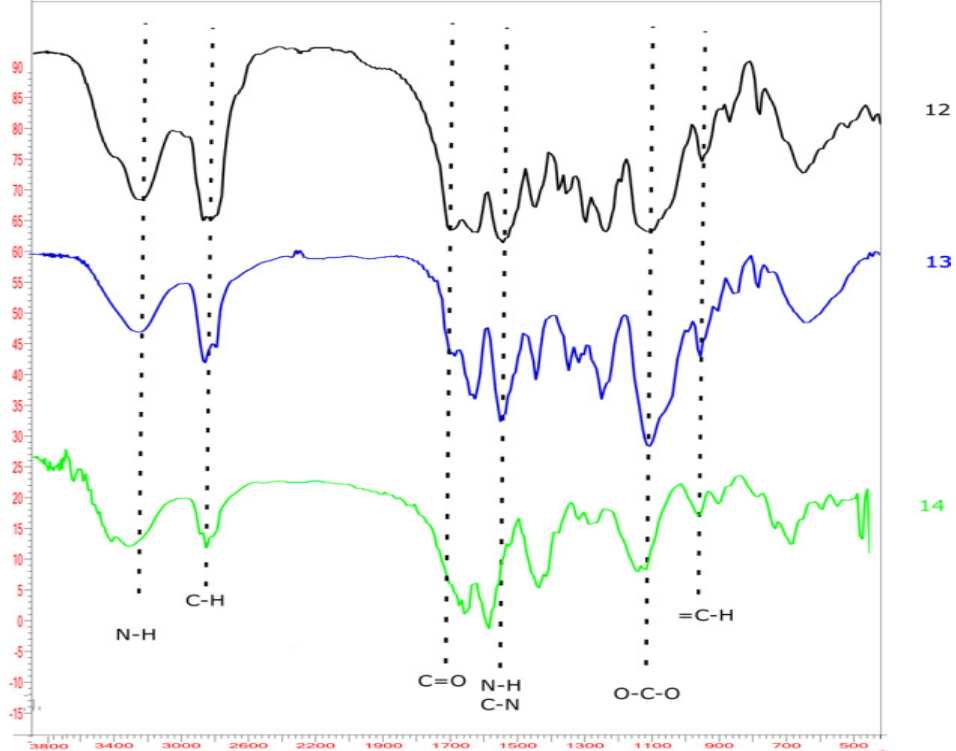
Figure 3. FT-IR spectrum of 14 that can confirm the presence of hydrogen bonds.